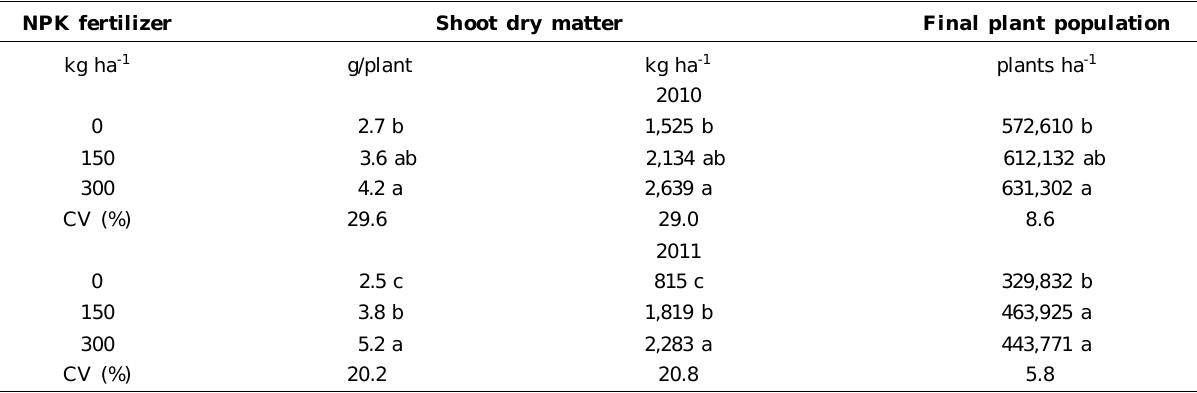
Values followed by different letters, in the column, were significantly different by the LSD test (p